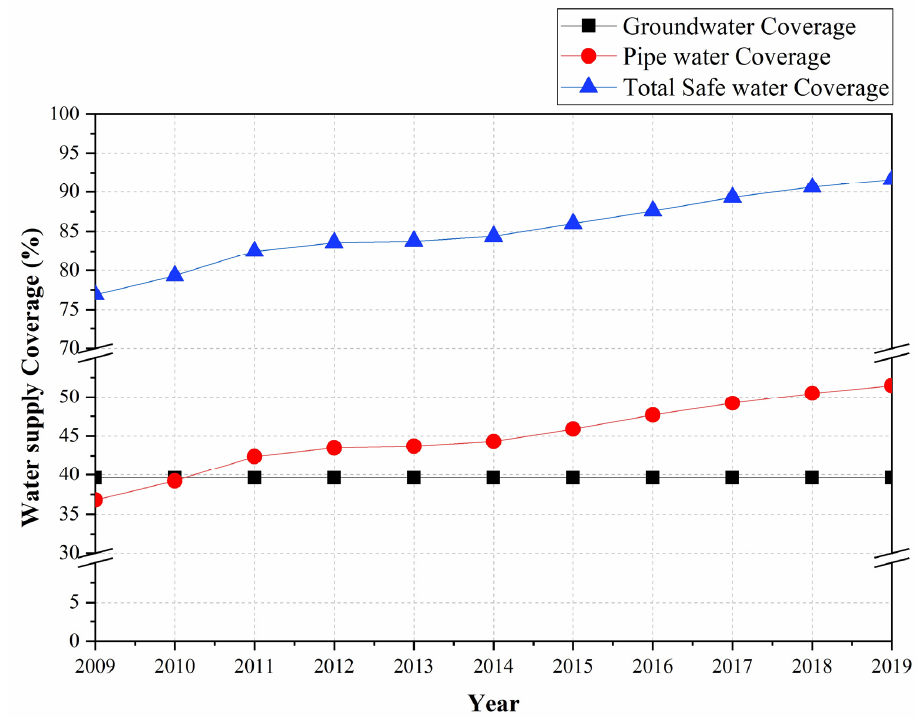
Figure 1. Progress of drinking water supply in Sri Lanka from 2009 to 2019